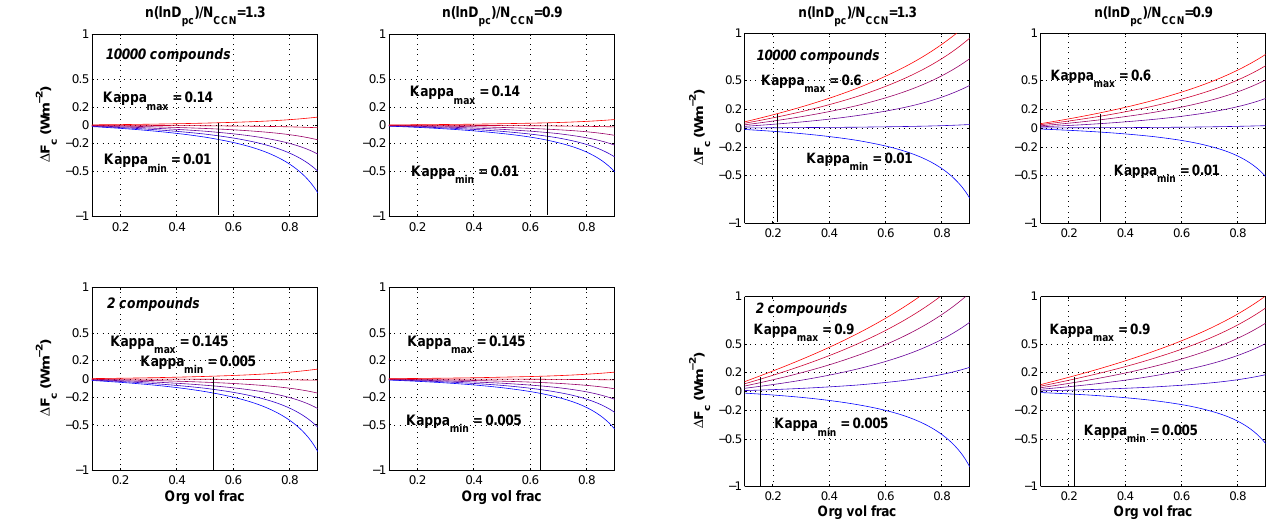
Fig. 6. Uncertainty in the first indirect effect 1F as a function of κ org and x org . The range of κ org were derived from simulations as- suming re-equilibration of all semi-volatile components to the dry state using two different method to calculate p 0 . The maximum κ org is represented by the top red line, the minimum κ org repre- sented by the blue line. Each column represents two different size distributions, the top plots 10000 compound simulations, the bot- tom plots 2 compound